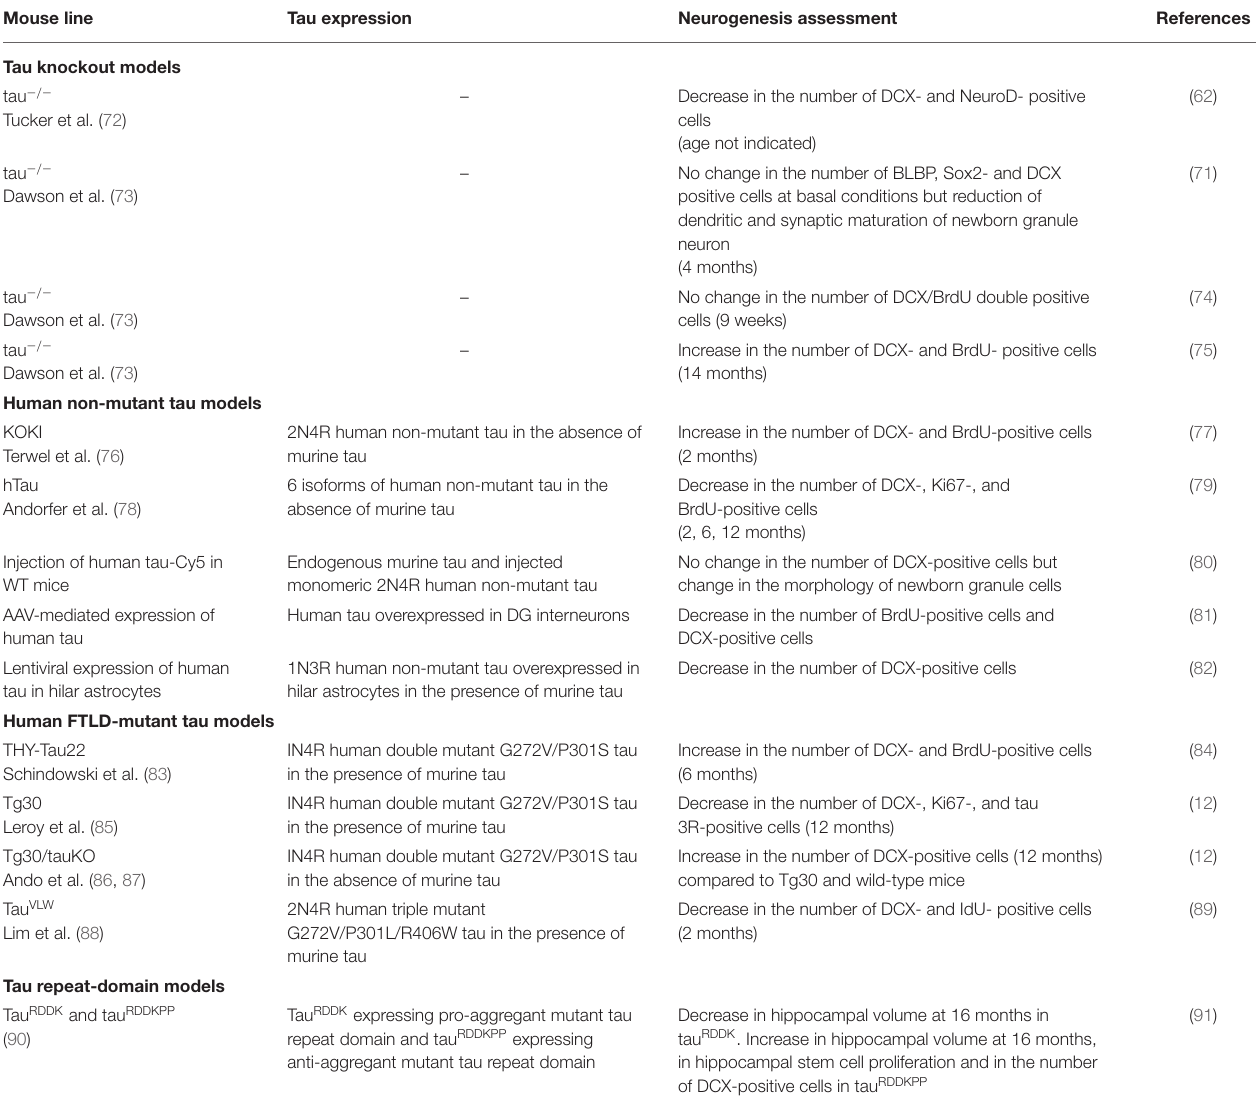
TABLE 1 | Summary of neurogenesis changes in tau mouse